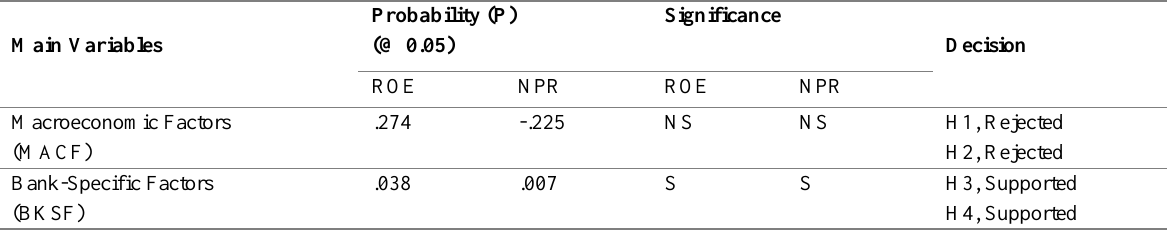
Table 7: Summary Table of Hypothesis, P-Values, and